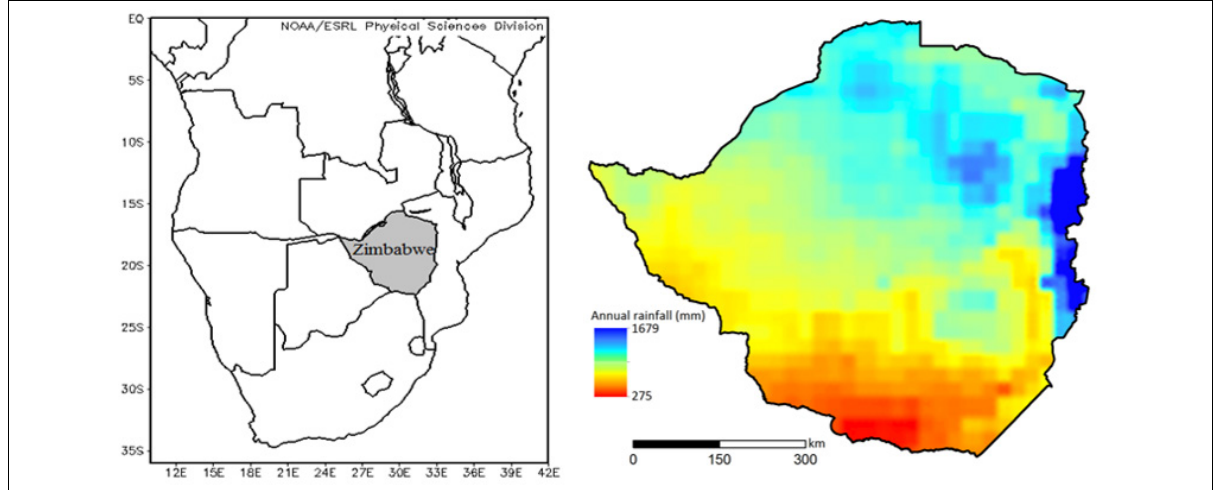
Figure 1: Map of southern Africa showing (a) the geographical position of Zimbabwe and (b) a map of the annual rainfall distribution in